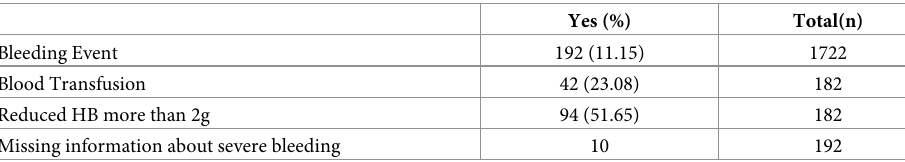
Table 1. Proportion of bleeding